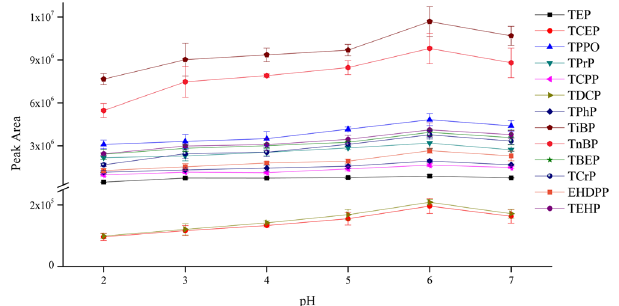
Figure 5. The efficiency of different pH on the extraction of OPEs from aqueous samples (n = 3).